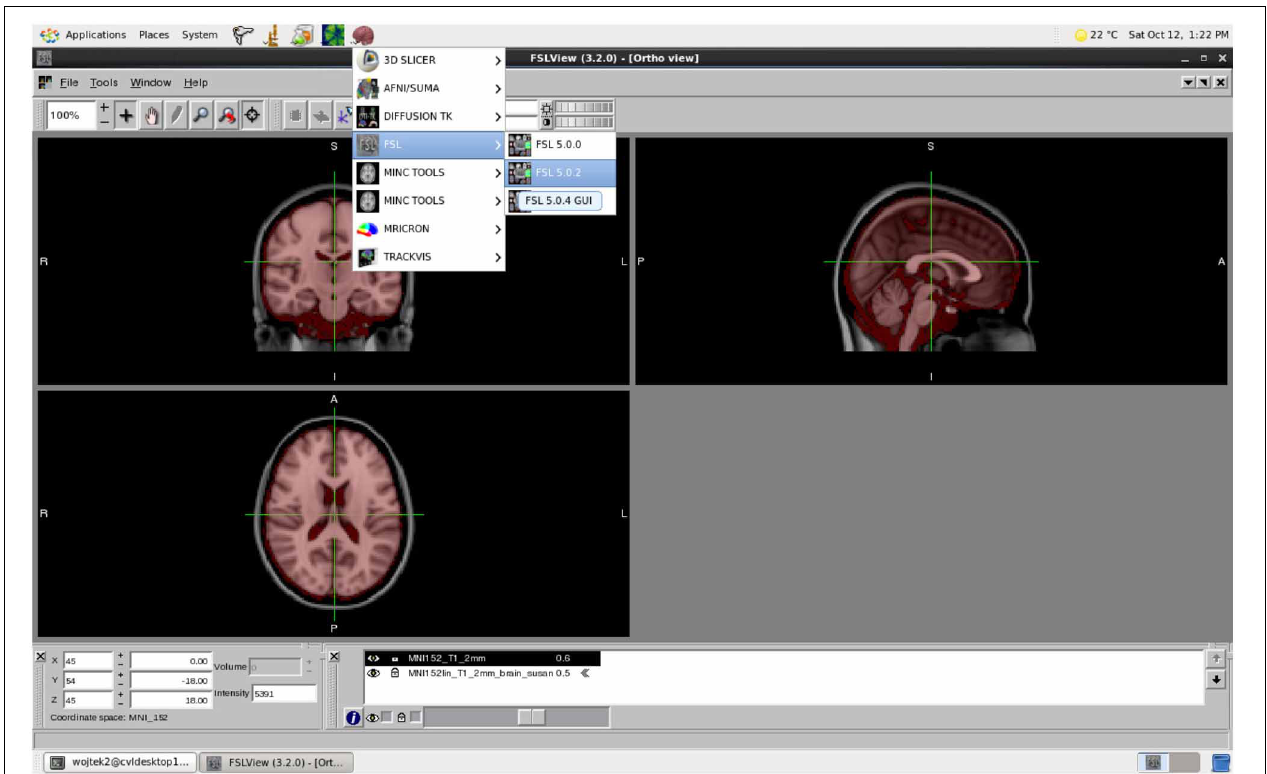
FIGURE 6 | The MASSIVE Desktop environment showing FSLView and a range of neuroinformatics tools available through the menu.